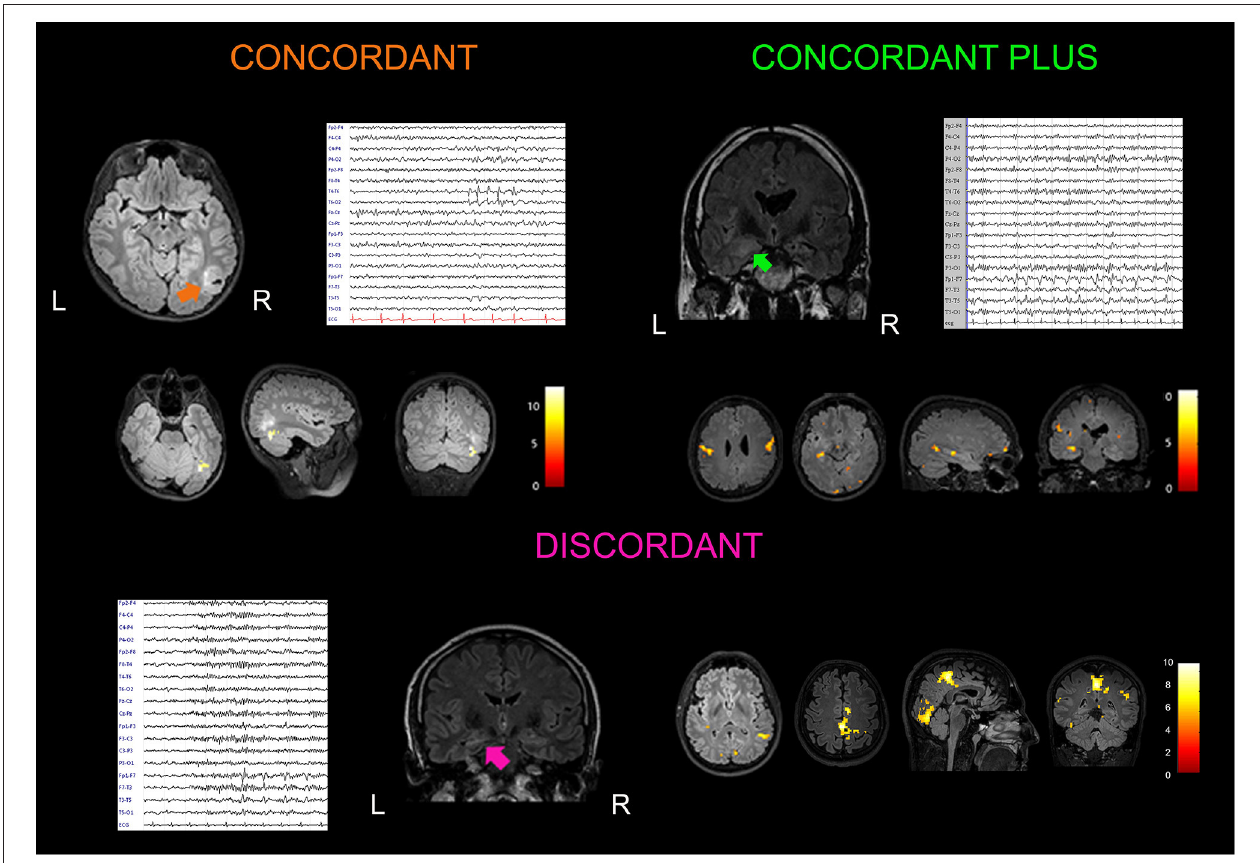
FIGURE 1 | Examples of concordant, concordant plus and discordant EEG–fMRI findings. Concordant: A 15-year-old boy with a history of febrile seizures in early childhood presented with a focal to generalized seizure occurring during sleep. Brain MRI showed a lesion localized at the border of the temporal and occipital cortex on the right side (arrow). Low-amplitude spike and waves were observed in the right posterior temporal and occipital electrodes (T6, O2) on scalp EEG. He received surgery (lesionectomy) with a good outcome (Engel Class Ib at 24 months of follow up). Histological analysis documented a polymorphous low-grade neuroepithelieal tumor of the young (PLNTY). EEG–fMRI analysis guided by interictal T6 spike-and-waves showed a cluster of BOLD signal increment localized inside the tumor. Coronal, sagittal, and axial slices of the patient’s structural MRI are displayed ( p < 0.05), FWE corrected. Concordant plus: A 37-year-old woman presented with a 6-year history of focal seizures occurring on a weekly base. She referred to two types of seizures: one with an epigastric aura ascending from the lower abdomen to the neck, nausea, and brief impairment of awareness; second seizure type was a focal aware seizure with a visual aura (visual shrinking and oscillation) with dizziness sensation. Structural MRI showed two lesions suggestive for focal cortical dysplasia localized in the right anterior mesial temporal lobe, and in the posterior part of the middle temporal cortex. EEG confirmed two epileptic foci in the right temporal lobe, one anterior temporal (F8) and the other localized in the middle posterior temporal derivations (T4, T6). The patient refused surgery after seizures improvement with pharmacological treatment. EEG–fMRI showed BOLD changes in the right temporal lobe with a cluster in the vicinity of the posterior middle-temporal lesion, plus other clusters of increased BOLD changes localized at distant cerebral structures (ipsilateral and contralateral parietal, precentral, and occipital gyrus; p < 0.001, uncorrected for multiple comparisons). Discordant: A 40-year-old man with left hippocampal sclerosis presented frequent focal seizures characterized by epigastric aura, aphasia, and oral automatisms. Scalp EEG abnormalities were represented by infrequent spikes and waves visible in the anterior temporal derivations (F7, T3). Excellent seizure outcome (Engel Class Ia) was obtained after standard left anterior temporal lobectomy. EEG–fMRI showed widespread fMRI changes localized outside the left temporal lobe and involving cerebral structures belonging to the motor, visual, and DMNs ( p < 0.001, uncorrected for multiple